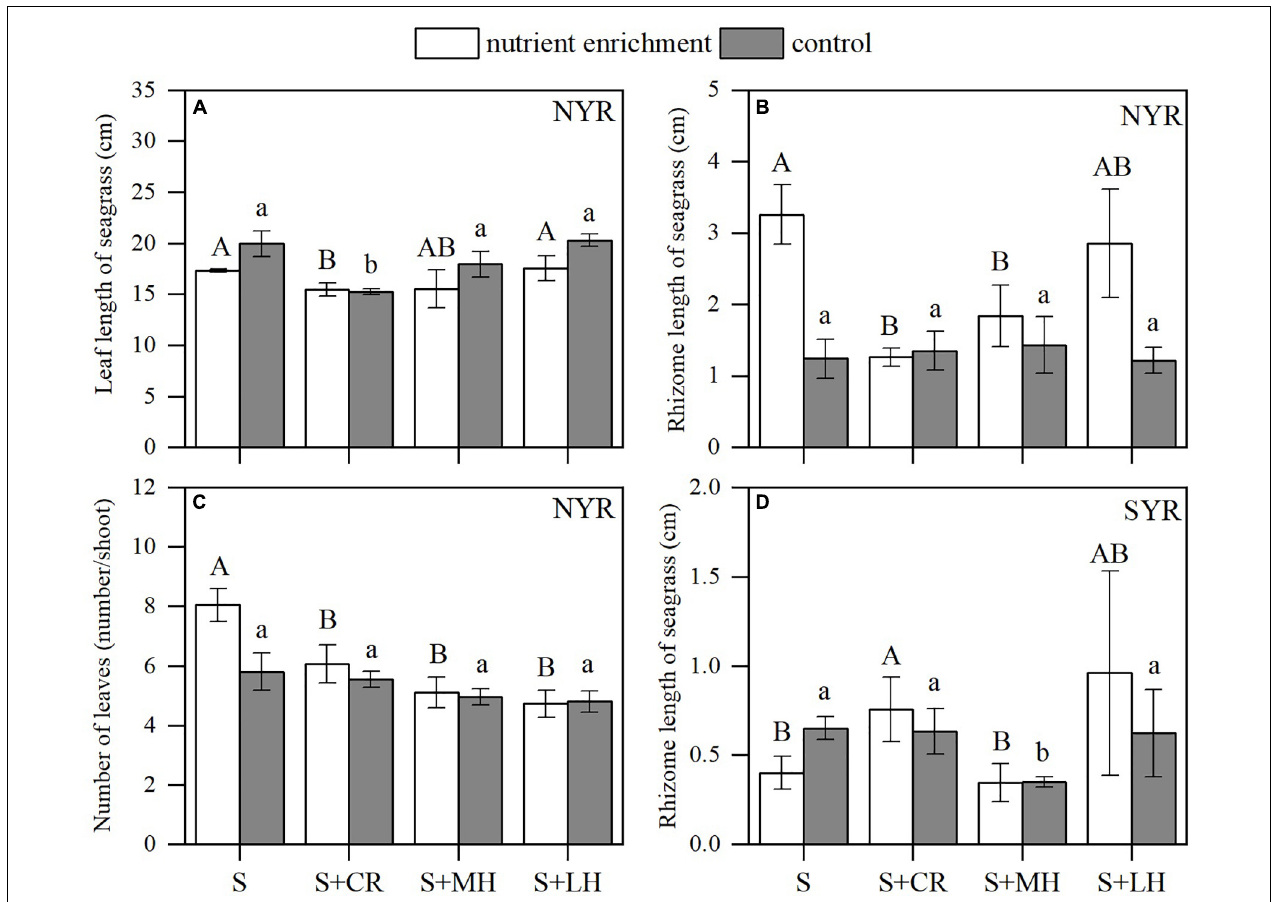
FIGURE 4 | Effects of nutrient enrichment and herbivory on the morphological characteristics of seagrass (mean ± SE , n = 4). (A) Leaf length in the NYR; (B) rhizome length in the NYR; (C) number of leaves in the NYR; (D) rhizome length in the SYR. Within nutrient treatments (enrichment or control), bars sharing a letter are not significantly different from one another ( p > 0.05).